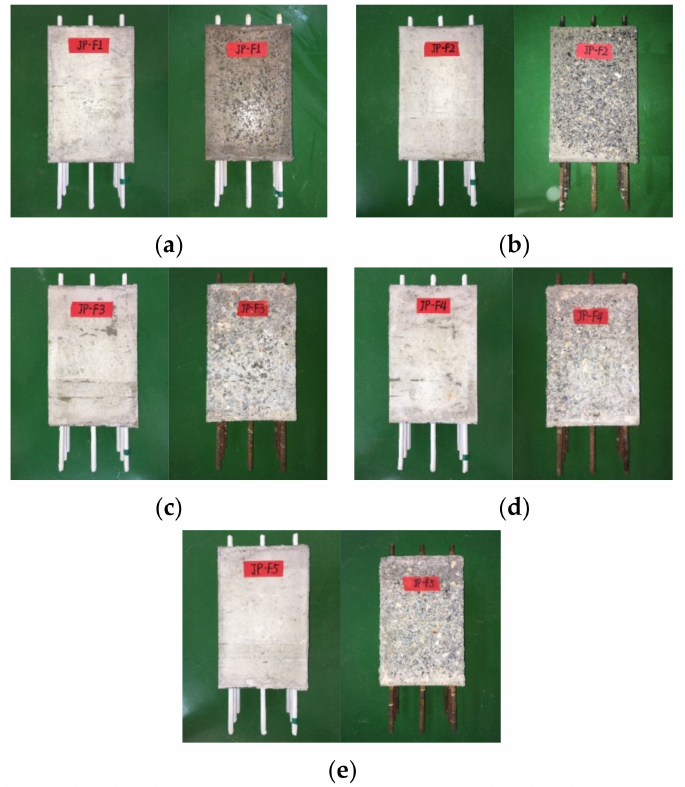
Figure 18. Experimental results of the rapid freeze–thaw cycles. ( a ) Comparison before and after 25 freeze–thaw cycles. ( b ) Comparison before and after 50 freeze–thaw cycles. ( c ) Comparison before and after 75 freeze–thaw cycles. ( d ) Comparison before and after 100 freeze–thaw cycles. ( e ) Comparison before and after 125 freeze–thaw cycles. After the seawater freeze–thaw cycle test, the assembly and the secondary pouring work were carried out on the specimens, as shown in Figures 19 and